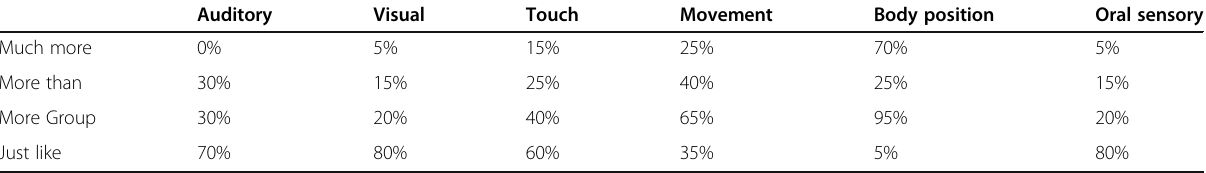
Table 2 Distribution of All children with SCP according to their response to sensory systems Auditory